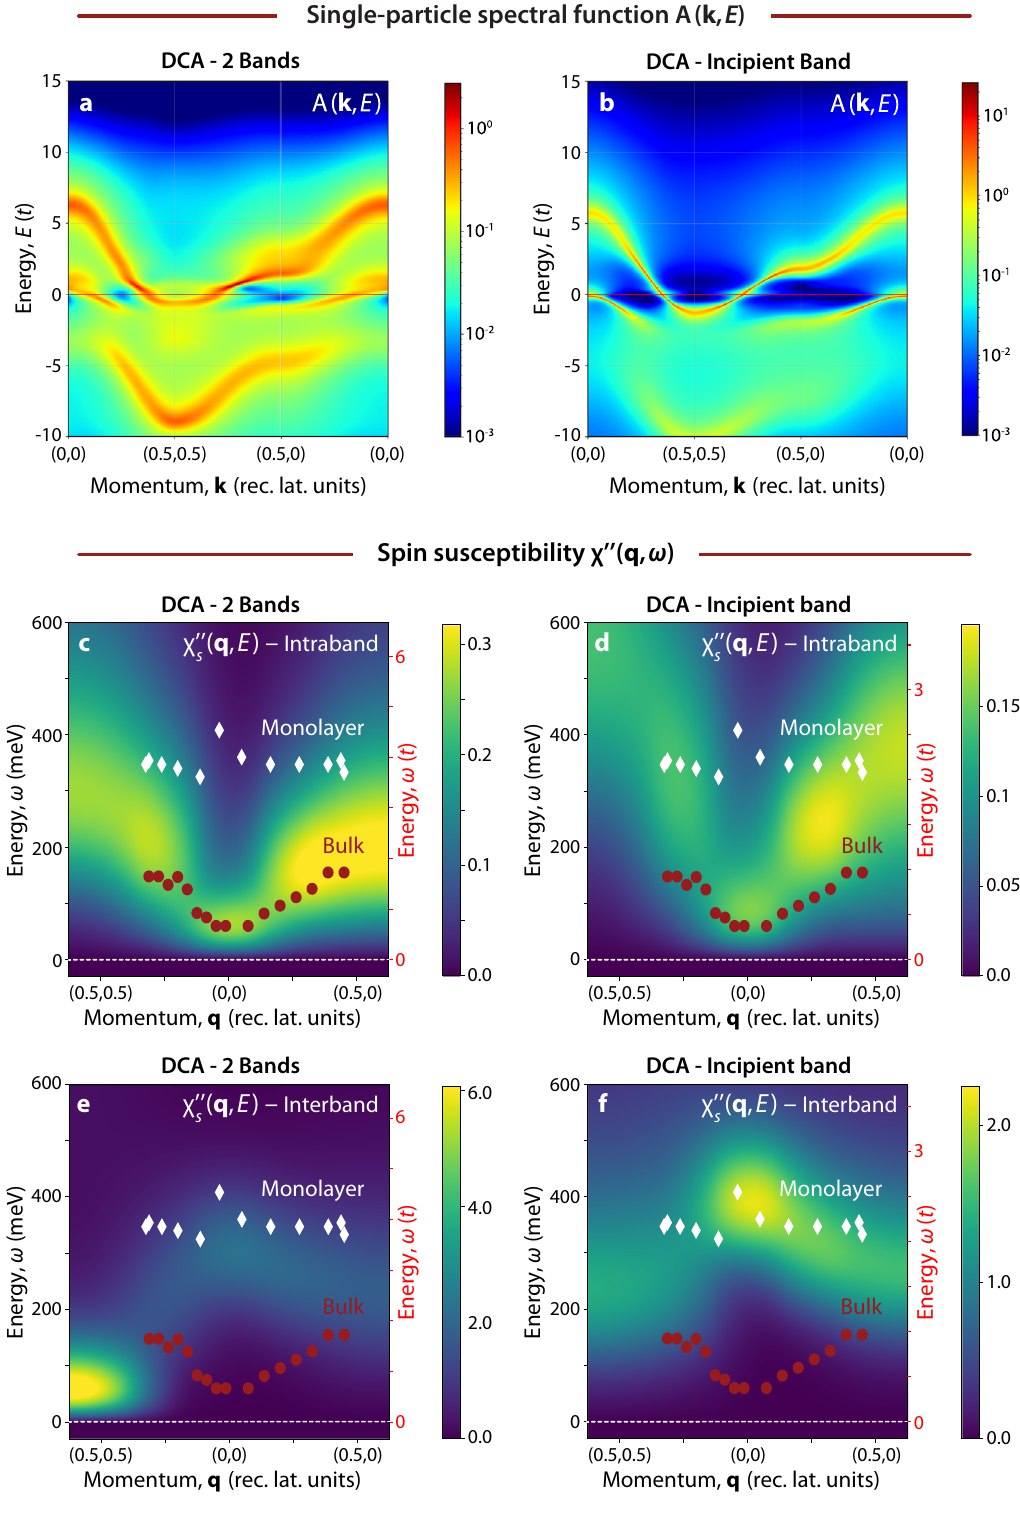
Fig. 3 Single-particle spectral function and dynamical spin susceptibility from Dynamical Cluster Approximation (DCA) calculations. a , b DCA calculations and spectral function A ( k , E ) for the two-band Hubbard model ( a ) and the incipient band Hubbard model ( b ). c – f DCA calculations of the imaginary part of the spin susceptibility χ 00 s ð q ; ω Þ for the two-band Hubbard model ( c : intraband Q z = 0; e interband Q z = π ) and the incipient band Hubbard model ( d intraband Q z = 0; f interband Q z = π ). Red circles (white diamonds) indicate the energy position of the peak detected by Resonant Inelastic X-Ray Scattering (RIXS) in bulk (monolayer) FeSe. The uncertainties associated with peak fi tting are smaller than the